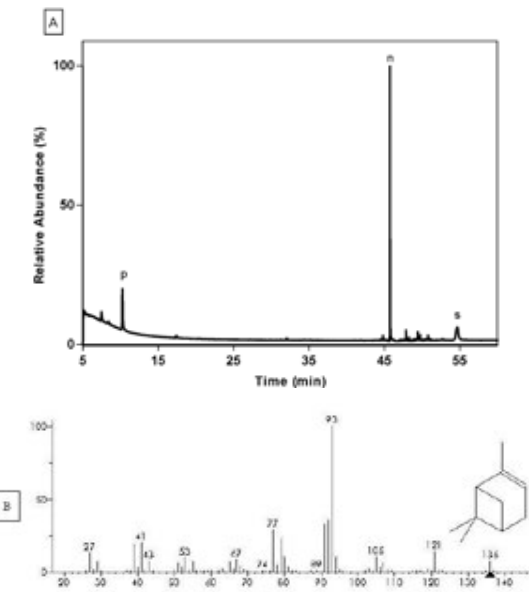
Figure 4. (A) TIC from calluses inoculated with 10 μL of 10 9 conidia mL -1 . The peaks in TIC correspond to α-pinene (10.28 min, p), nerolidol (45.74 min, n), and squalene (54.65 min, s). (B) MS spectra of